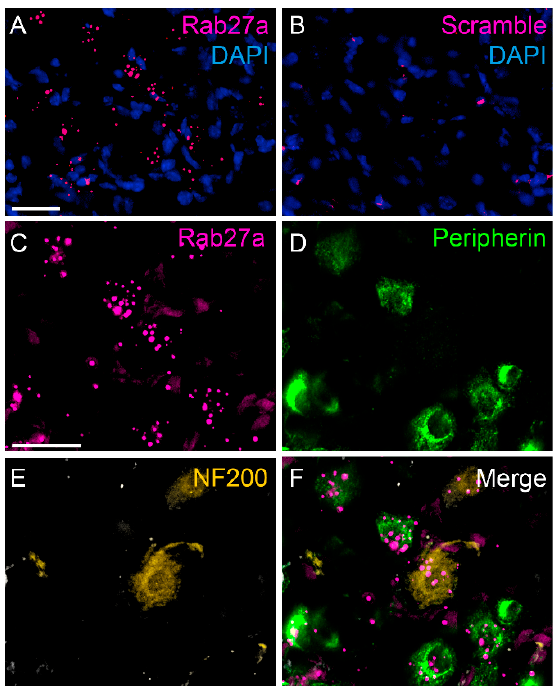
Figure 3. Localization of Rab27a mRNA in dorsal root ganglia. ( A ) Fluorescent in situ hybridization detected Rab27a mRNA in DRG neurons and non-neuronal cells. ( B ) No hybridization signal was detected using scramble (negative) control. ( C – F ) In DRG neurons Rab27a mRNA colocalizes with peripherin-positive and NF200-positive DRG neurons. Scale bars: A and C = 25 µ m.